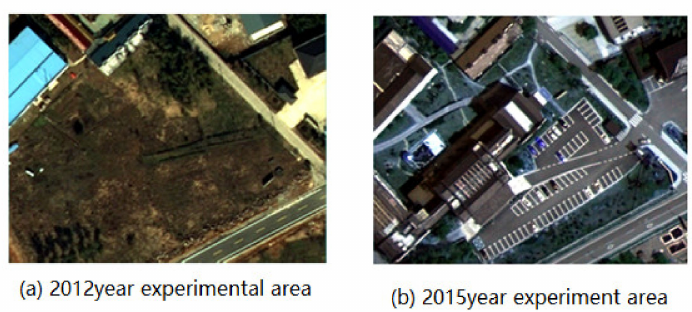
Figure 4. Original spectra